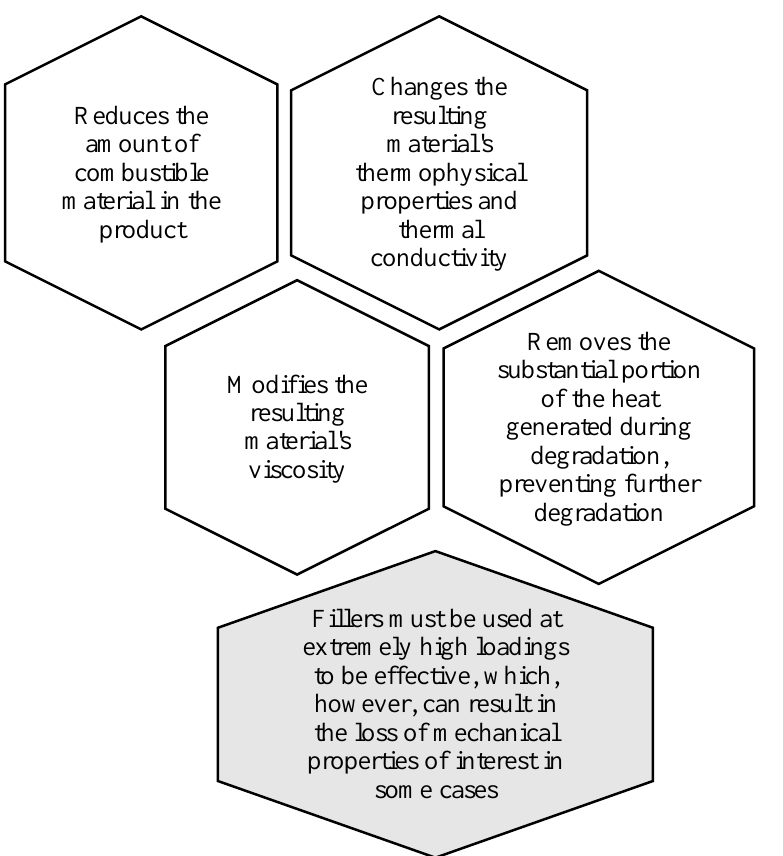
Figure 8. Objective of inorganic fillers in flame retardant coatings [87,240 – 247].